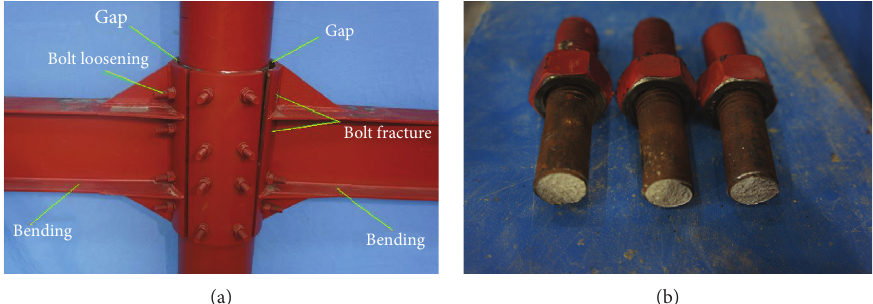
Figure 7: Failure modes of J-1: (a) steel beam bending; (b) bolt fracture.